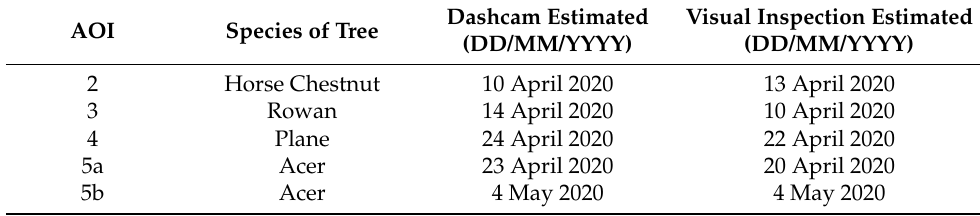
Table 3. Start-of-green-up date for each